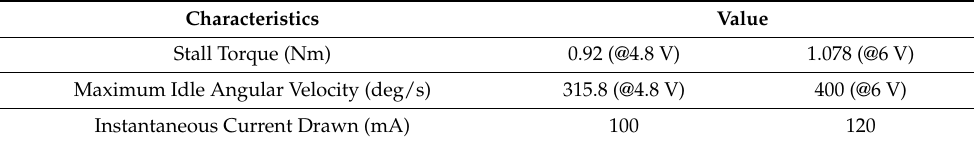
Table 3. Specification of TowerPro MG996R digital high torque metal gear servo motor.